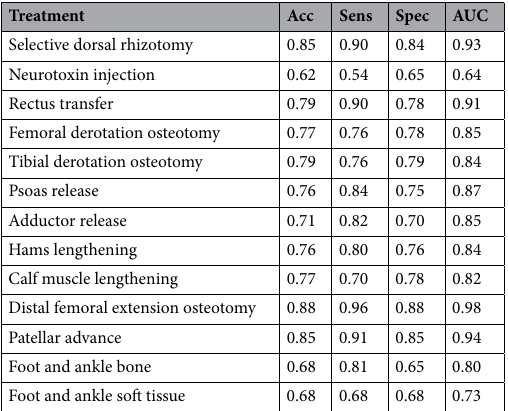
Table 7. Performance of propensity score models. Acc accuracy, Sens sensitivity, Spec specificity, AUC area under the receiver operation characteristic curve. All results are for out-of-sample (independent) test